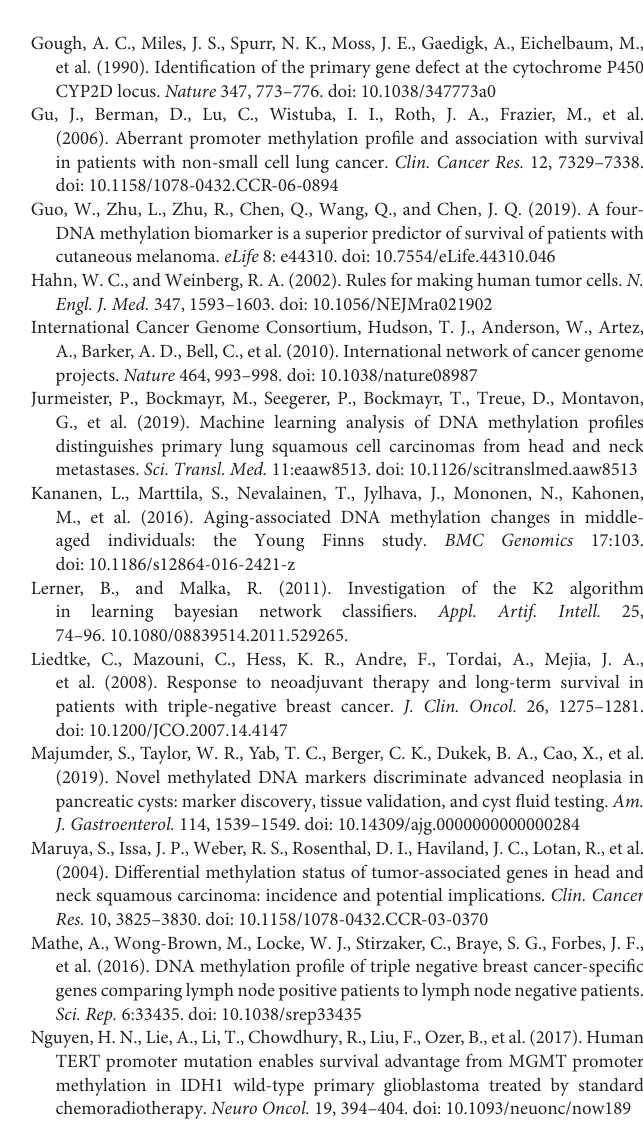
Supplementary Figure 1 | The correlation between 7 DMSs and corresponding genes. Pearson correlation test was used. Supplementary Figure 2 | Unsupervised cluster analysis of 7 DMSs in BRCA and adjacent tissues. Supplementary Table 1 | Profile of healthy blood sample (GSE69270). Supplementary Table 2 | Differentially methylated sites in the blood (GSE69270). Supplementary Table 3 | The profile of GSE66695. Supplementary Table 4 | The profile of GSE60185. Supplementary Table 5 | The profile of GSE78754. Supplementary Table 6 | The DMSs were significantly correlated with corresponding gene expression. Supplementary Table 7 | DNA methylation sites associated with OS significant. Supplementary Table 8 | Genes significantly related to 6 CpG sites on DNA replication and cell cycle